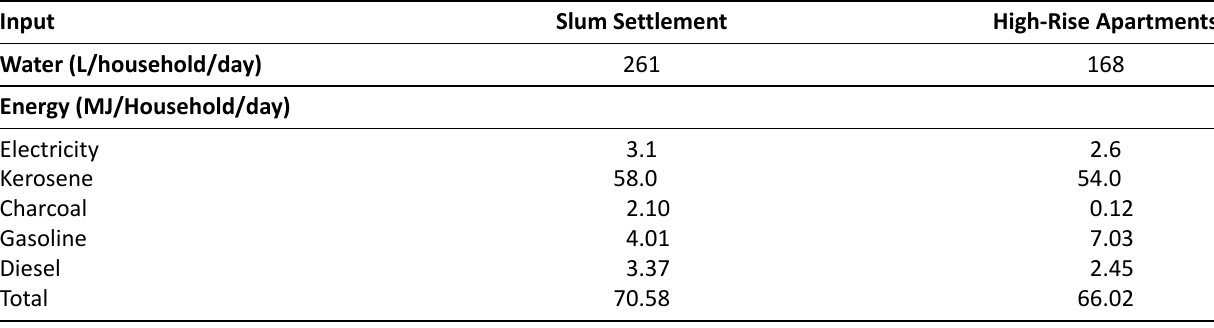
Table 4. Resource inputs to Arat Kilo Slum Settlement and High-Rise Apartments, Addis Ababa. Source: Authors’ filed data.